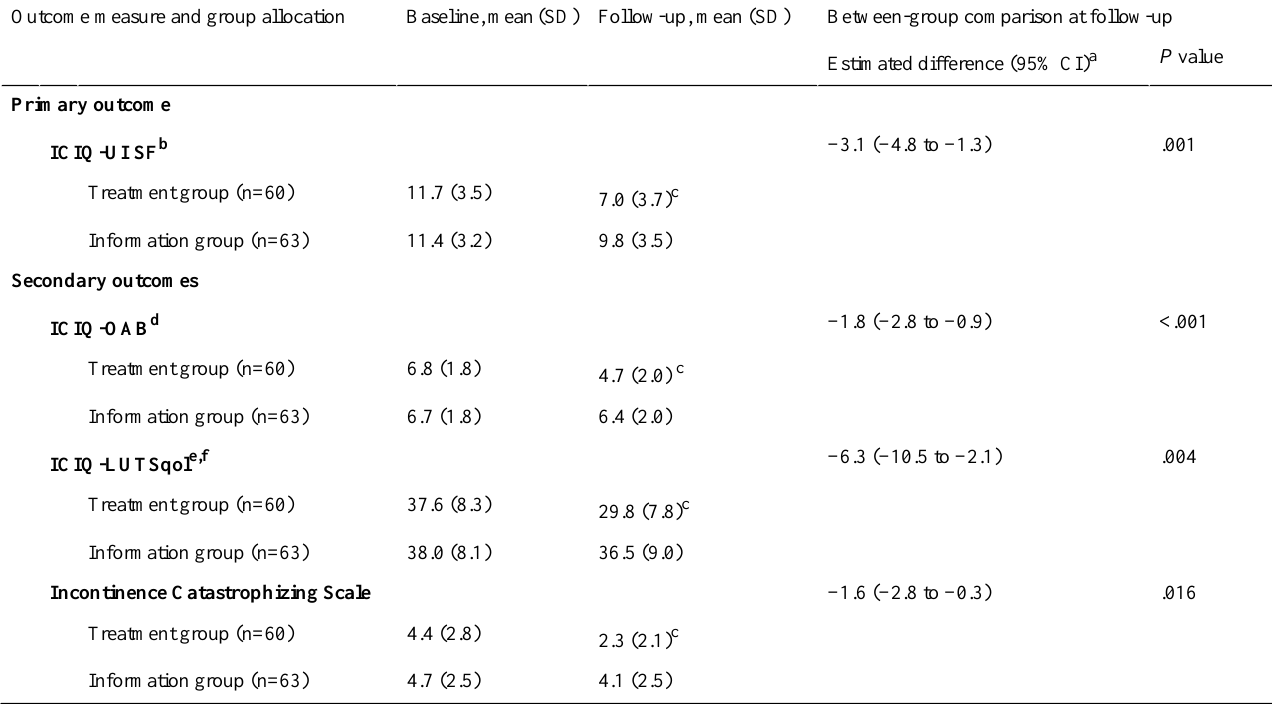
Table 3. Continuous outcomes compared between the treatment group (n=60) and information group (n=63) at follow-up.